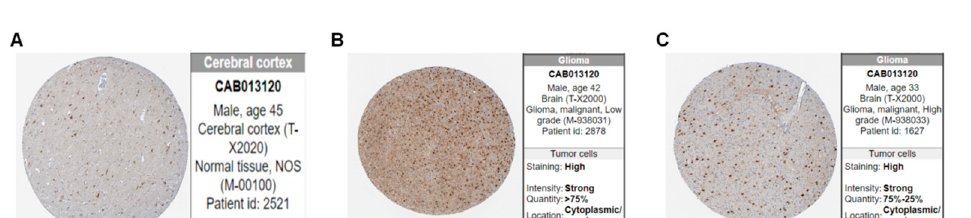
Figure 3. Immunohistochemical image of IL10 on the HPA website. ( A ) Normal tissue. ( B ) Low- grade glioma. ( C ) High-grade glioma. Table 2. Top 10 genes in the network ranked by the Degree method.